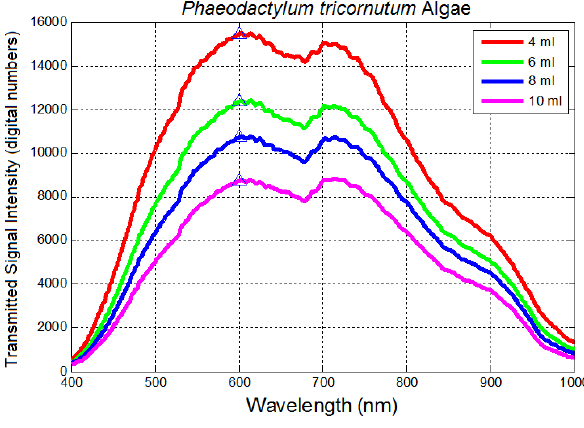
Figure 12. Transmitted signal intensity (average raw spectra) within 400–1,000 nm with volumes of Phaeodactylum tricornutum algae samples in (fixed Petri dish size); 600 nm is used for logarithmic calculations.